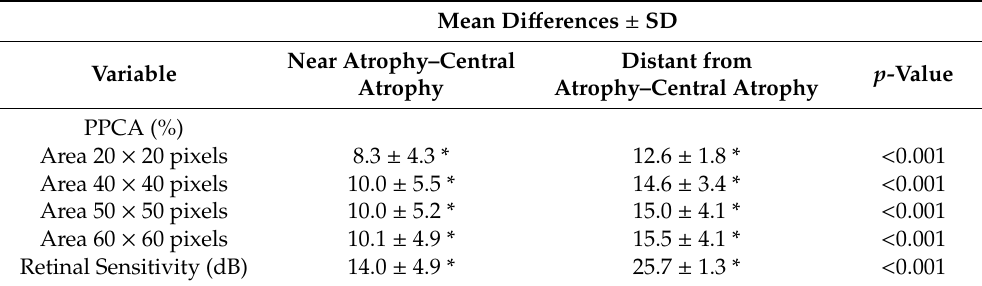
central atrophy. PPCA: Percent perfused choriocapillaris area. 24